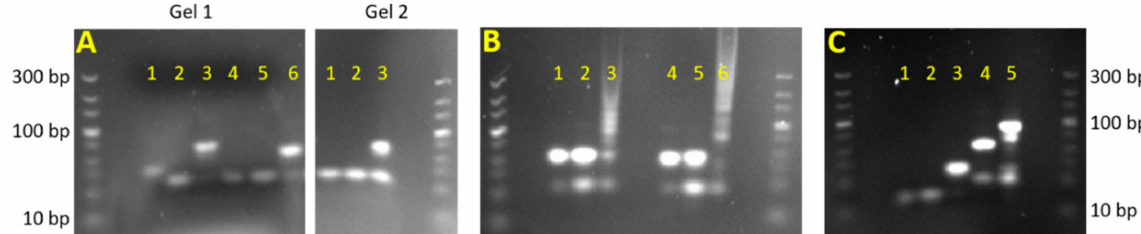
Figure 4. Gel electrophoresis results for D-DNA dumbbell binding studies. The same DNA ladder is used throughout, and shown at the right and left sides of each gel. ( A ) Gel 1, lanes 1-3: U1-a*, U1-b, and U1*. Gel 1, lanes 4-6: U1-a, U1-b, and U1. Gel 2, lanes 1-3: U2-a, U2-b, and U2. ( B ) Lanes 1–3: U1, U2, and U1+U2. Lanes 4–6: identical, but with 5 (cid:48) FAM fluorescent labels. ( C ) Lane 1: capture probe. Lane 2: target. Lane 3: capture+target. Lane 4: U1*. Lane 5: capture + target +